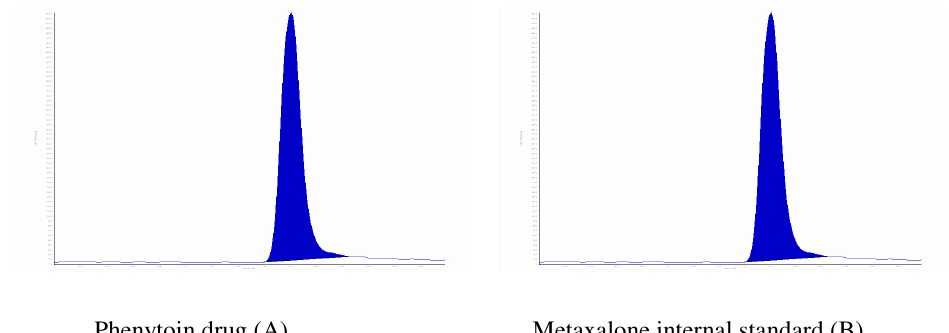
Figure 3b . Representative chromatograms of (B) Plasma spiked with Phenytoin drug and Metaxalone internal standard at the lower limit of quatification.